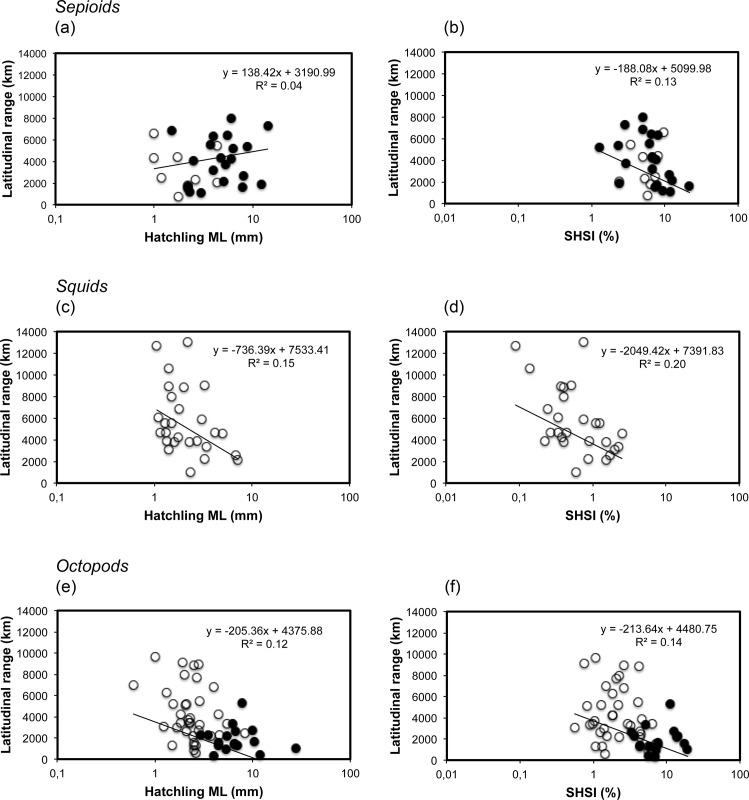
Relationship between hatchling size in mantle length (ML) and species hatchling size index (SHSI) with the latitudinal distribution range of cephalopod species hatched in the laboratory for the major cephalopod groups.a), c), e), relationship between hatchling size and latitudinal distribution range of the species; b), d), f), relationship between the SHSI and the latitudinal distribution range of the species. Data from a) and b) are based on 30 species of sepioids, data from c) and d) are based on 27 species of squids, and data from e) and f) are based on 53 species of octopods. Logarithmic scale is used for the X-axis. Empty circles represent planktonic species; black circles benthic species.